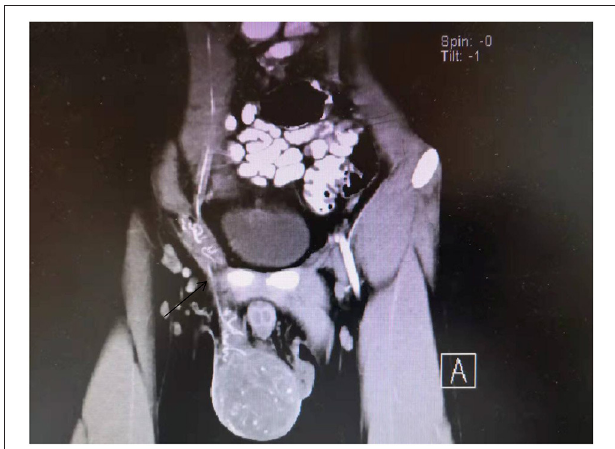
FIGURE 3 | Enhanced CT scan show that the spermatic vessels.